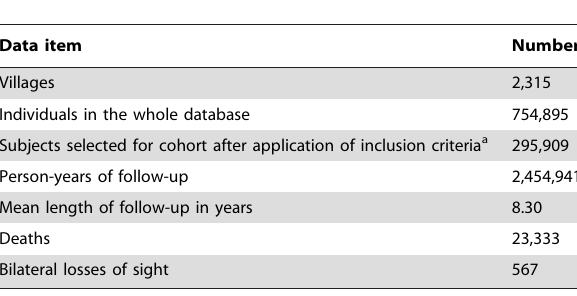
Table 1. Summary of mortality data collected by the onchocerciasis control programme in West Africa From 1974 through